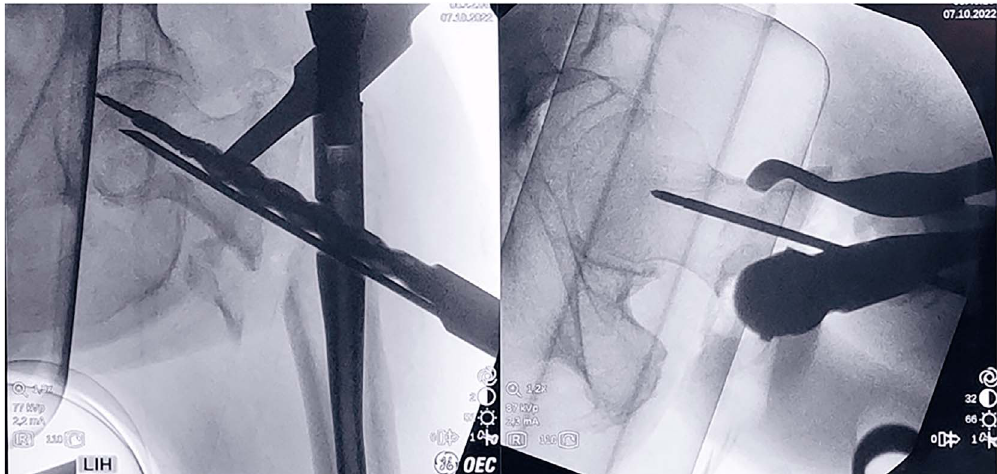
Figure 3. Position the guide in the correct TAD position and calculate the length of the interlocking lag screw. If we measure 100 mm, we deduct 15 mm which is the fracture gap we need to reduce, thus the length of the lag screw should be 85 mm. The compression screw length is 80